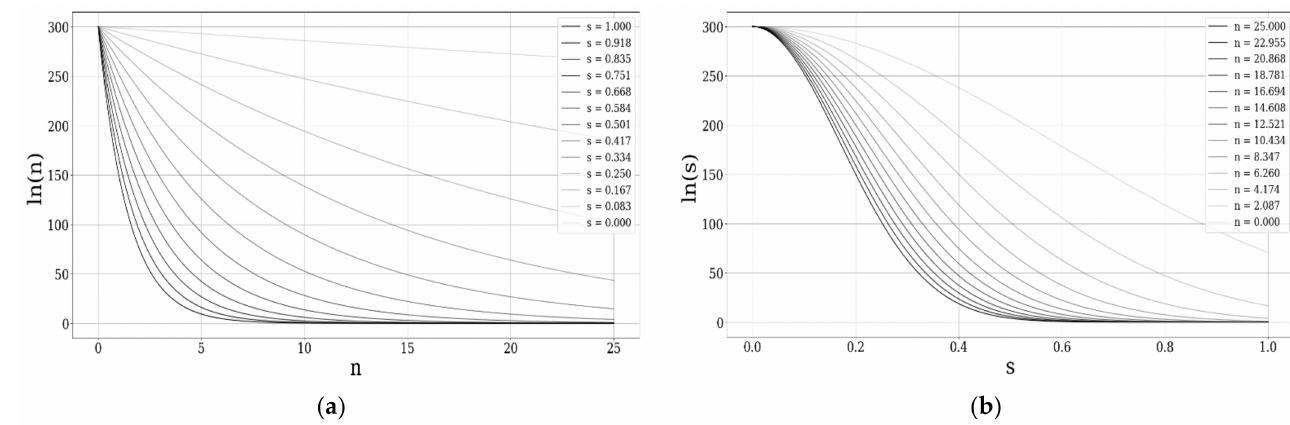
Figure 2. Lateral plot of l n : ( a ) as a function of n ; ( b ) as a function of s